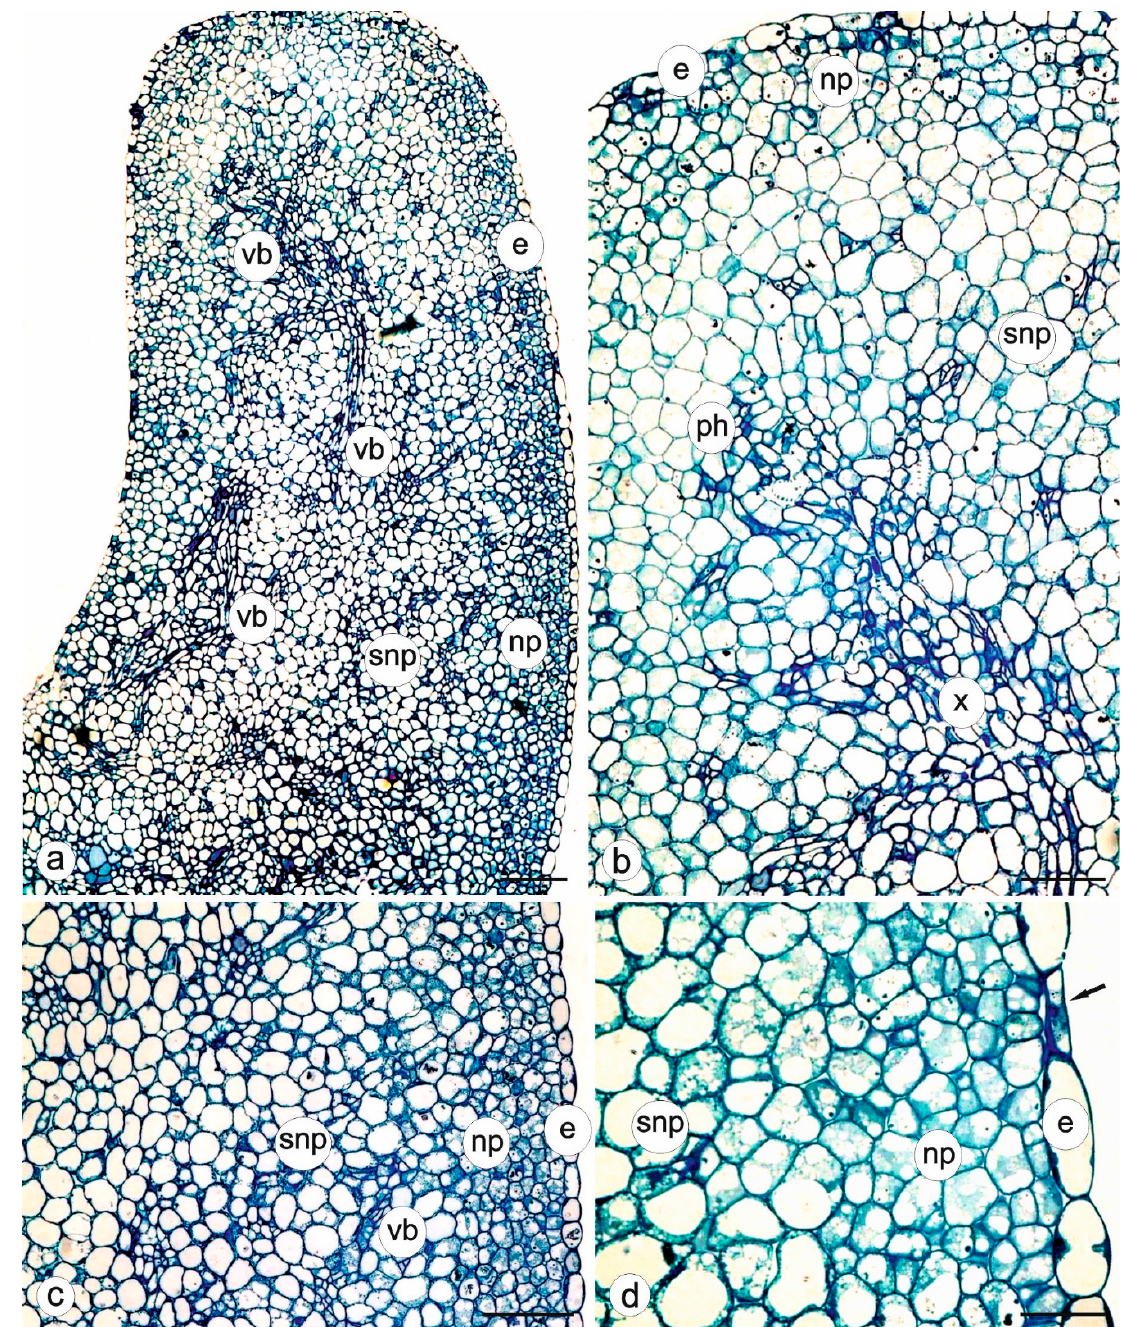
Figure 4. Anatomy of the floral nectary of Dracocephalum moldavica —light microscope (LM). ( a ) Longitudinal section of the longer nectary lobe; ( b ) Higher magnification of figure ( a ) showing branched phloem and xylem strands in subnectary parenchyma; ( c ) Fragment of the section of the lateral nectary part with visible epidermis, nectary parenchyma, and subnectary parenchyma as well as strands of vascular bundles; ( d ) Epidermis with stoma (arrow), nectariferous parenchyma, and subnectary parenchyma; e—epidermis; np—nectary parenchyma; snp—subnectary parenchyma; x—xylem; ph—phloem; vb—vascular bundle. Scale bars: 100 µ m ( a ), 50 µ m ( b , c ), 20 µ m ( d